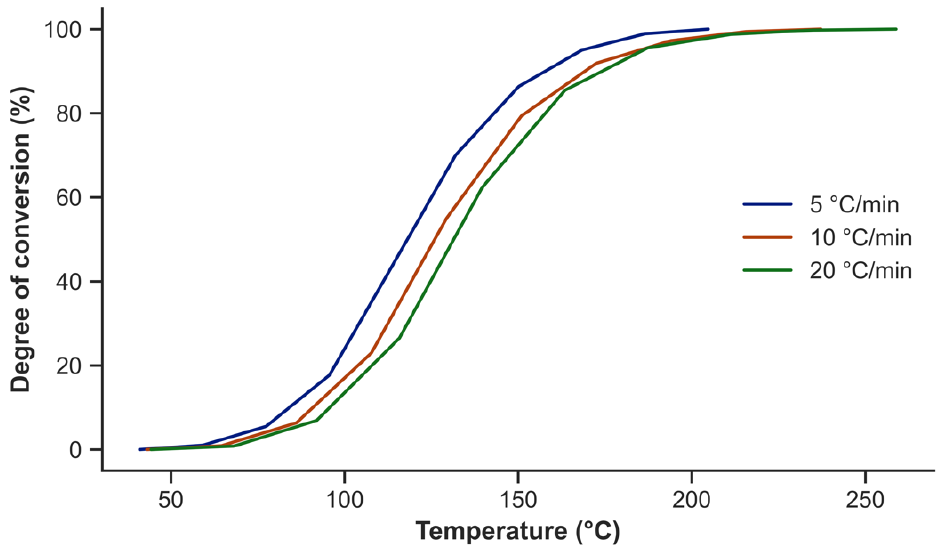
Figure 2. Temperature peaks as a function of heating rate for the epoxy resin. Figure 3. Degree of conversion as a function of temperature at different heating rates for the epoxy resin. Table 3. Curing peak temperatures and enthalpy of the epoxy resin.